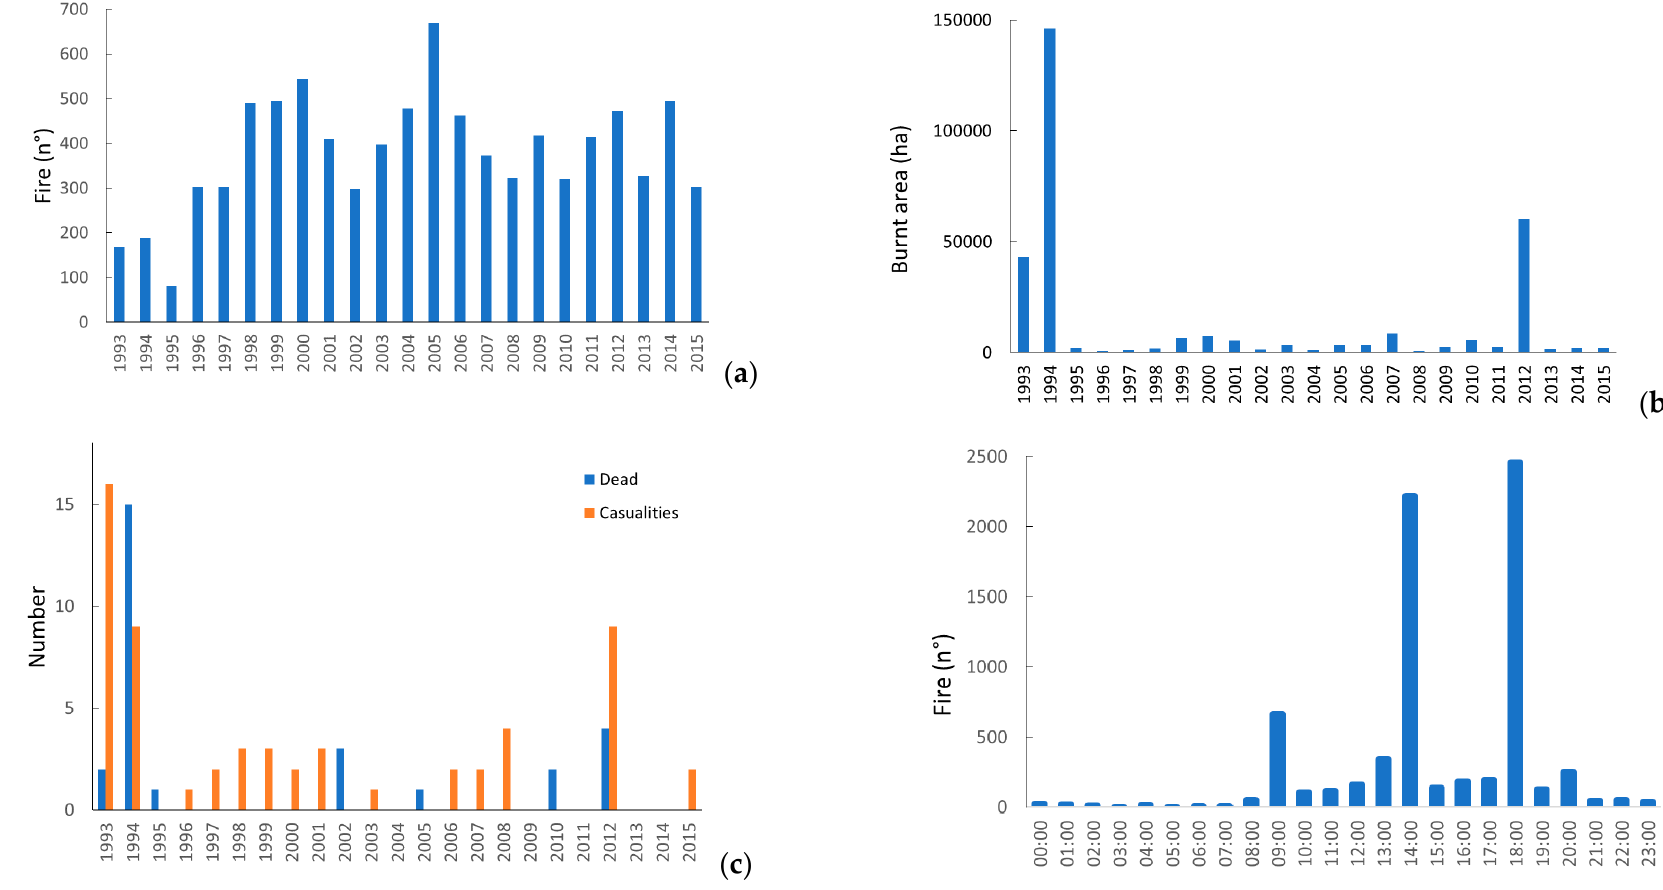
Figure 1. Number of fires ( a ), hectares of burnt surface area per year ( b ), number of fatalities ( c ) and daytime intervals when fires occurred ( d ) in the Valencian community, 1993 – 2015.